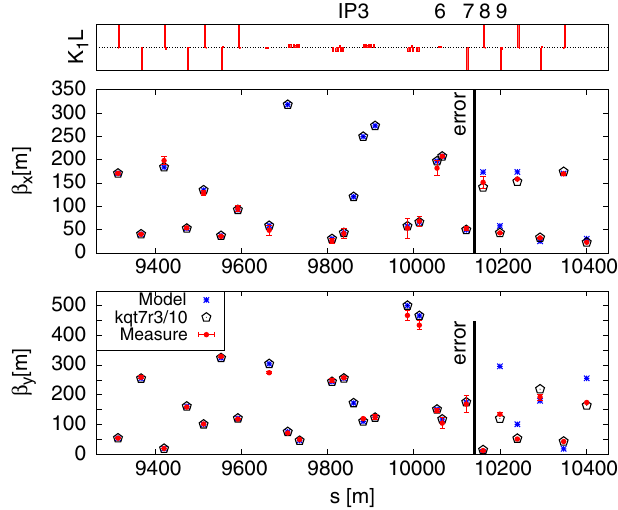
FIG. 6. (Color) Segment-by-segment approach in IR3. The top plot shows the gradient distribution versus longitudinal location. The two bottom plots show the horizontal and vertical beta functions from measurement and for two models (propagated by taking the initial (cid:4) and (cid:2) as